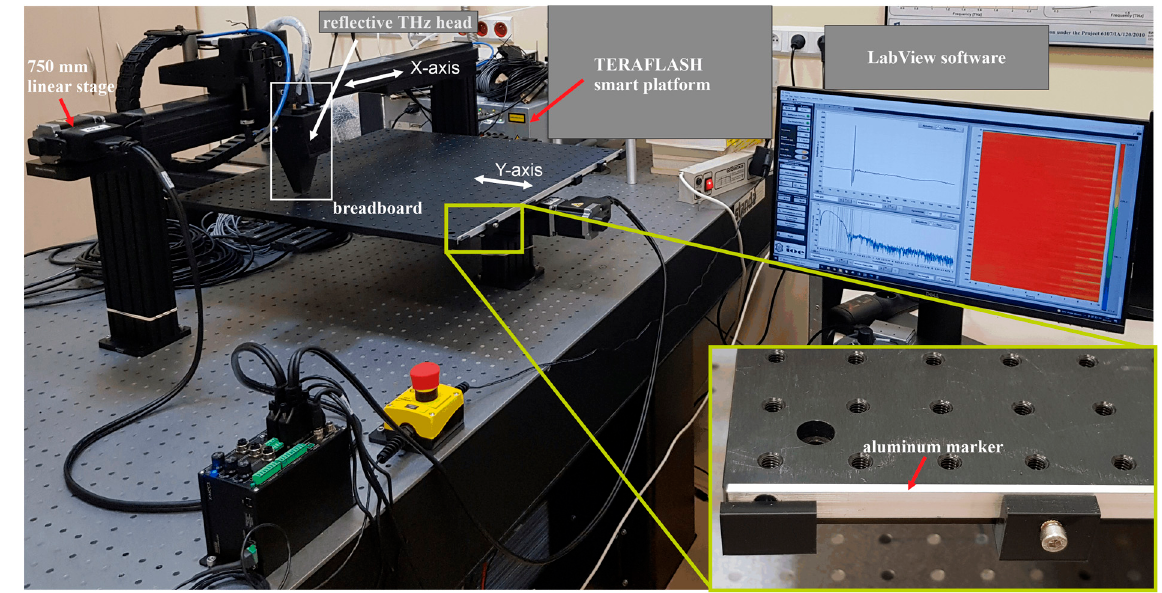
Figure 4. Photo of the ECOPS TDS system.